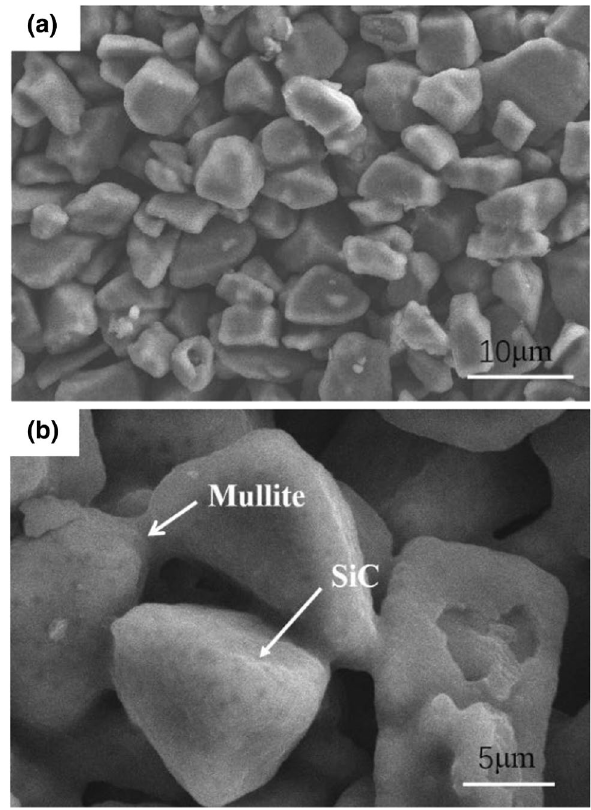
Fig. 3 SEM images of the sample SA prepared at 1500 °C for 2 h in the air